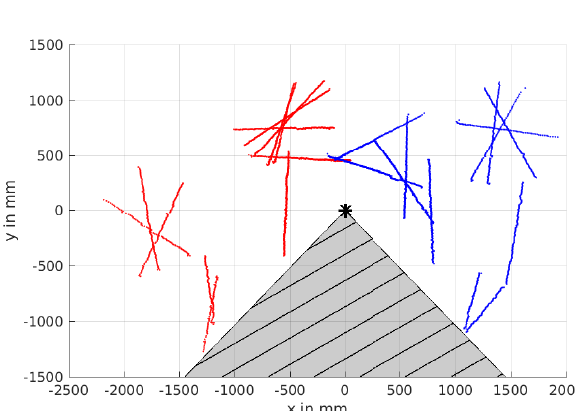
Figure 3: Extracted segments in laserscanner reference frame which are used to estimate the pose of the laserscanner w.r.t. the MCS. Red dotted markers represent the segments that correspond to planes extracted in the left camera, blue dotted markers corre- spond to planes extracted in the right camera. The black asterisk represents the origin and the hatched area is the blind angle of the laserscanner. By using all observations in an unified adjustment, compared to a single camera to laserscanner